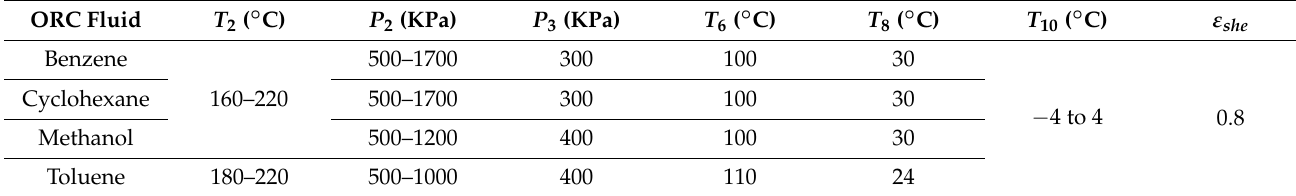
Table 9. Operating condition for the presentation of data for each analyzed fluid.